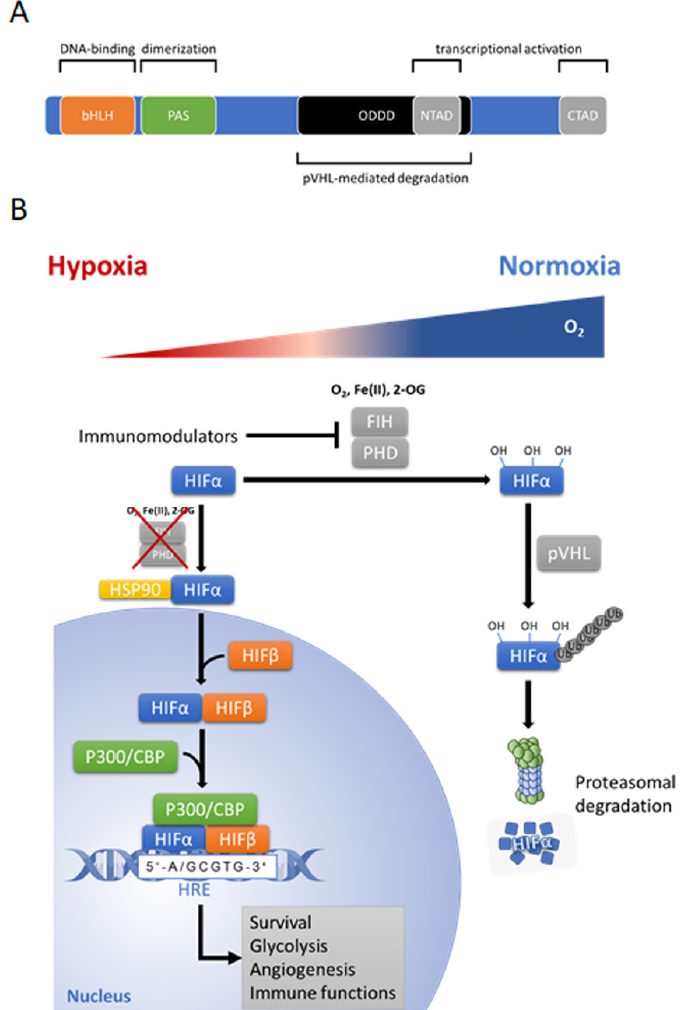
Figure 3. ( A ) Structure of hypoxia-inducible factor (HIF)-1 α /HIF-2 α subunit. Basic helix-loop-helix (bHLH) domain of HIF- α mediates DNA binding, and PAS domain is required for heterodimerization of the subunits. N-terminal transactivation domain (N-TAD) and the C-terminal transactivation domain (C-TAD) are transactivation domains for activation of HIF target genes. The N-TAD is responsible for the stability and target gene specificity and overlaps with the oxygen-dependent degradation domain (ODDD). The C-TAD interacts with coactivators activating gene transcription. Protein von Hippel–Lindau (pVHL)-mediated degradation of HIF- α needs hydroxylation of two proline residues in (ODDD). ( B ) Cellular HIF- α regulation under hypoxic (red shaded area of triangle) and normoxia conditions (blue shaded area of triangle). In hypoxia, HIF- α subunit translocates into nucleus and dimerizes with constitutively expressed HIF- β subunit, then recruits the transcriptional coactivator p300 and CREB (cAMP response element binding)-binding protein (CBP) to form a complex, which binds to hypoxic response elements (HRE) on DNA and triggers HIF-dependent transcriptional response. Under normoxic condition, when cellular oxygen supply exceeds demand, HIF- α is hydroxylated on prolyl residues by prolyl hydroxylase domain proteins (PHDs), which are members of 2-oxoglutarate (2-OG)-dependent dioxygenase superfamily and function in the present of substrates and co-factors: oxygen (O2), 2-oxoglutarate (2-OG), ferrous iron [Fe (II)] and ascorbate. Hydroxylation facilitates the interaction with the tumor suppressor protein von Hippel– Lindau (pVHL), which recruits an E3-ubiquiine-ligase complex tagging HIF by polyubiquitination for proteasomal degradation via the 26S proteasome. Furthermore, factor-inhibiting HIF (FIH) hydroxylates HIF and inhibits the transcriptional activation of HIF by preventing recruitment of the transcriptional coactivators p300 and CBP. Figure was modified from Servier Medical Art, licensed under a Creative Common Attribution 3.0 Generic License